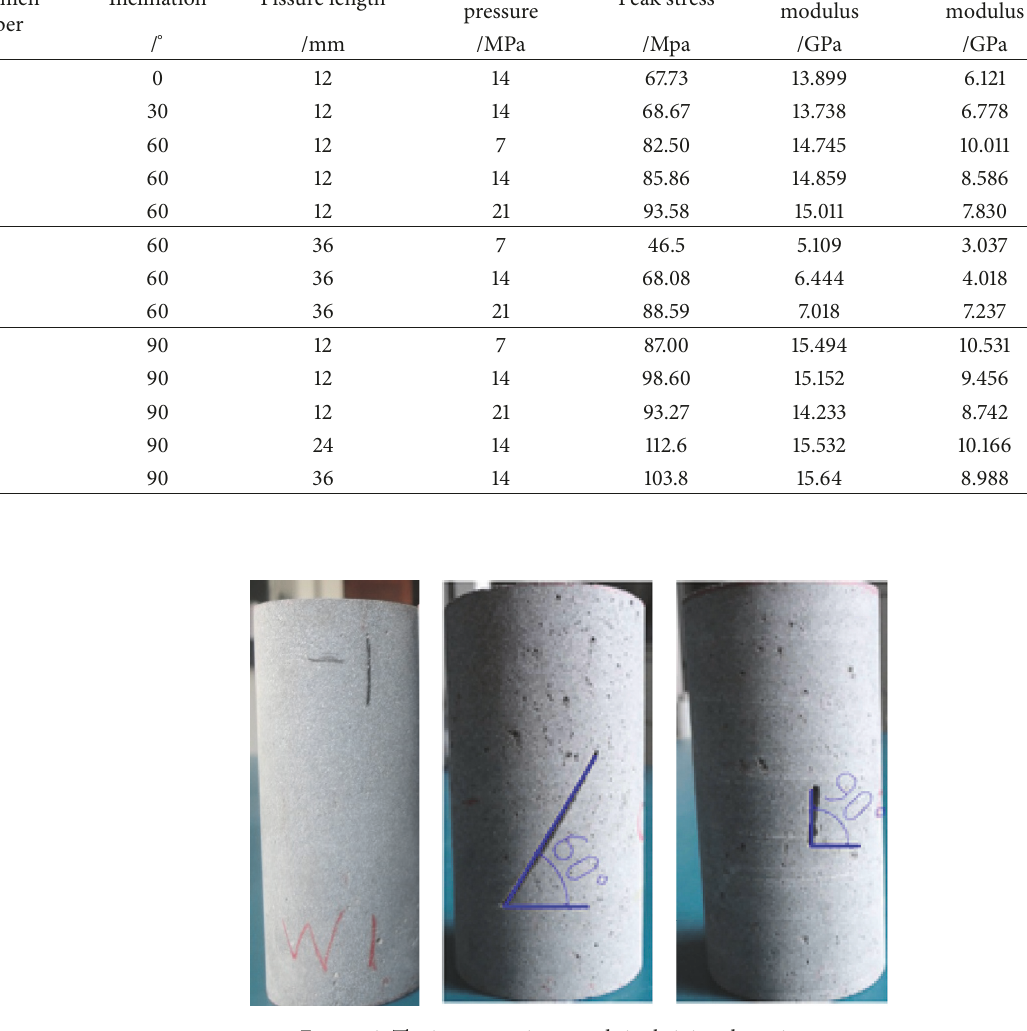
Figure 2: The intact specimen and single jointed